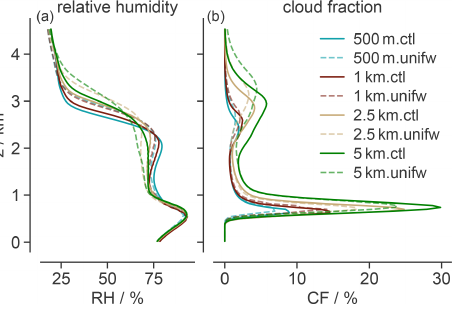
Figure 7. As in Fig. 6 but for 500m, 1km, 2.5km and 5km resolu- tion.